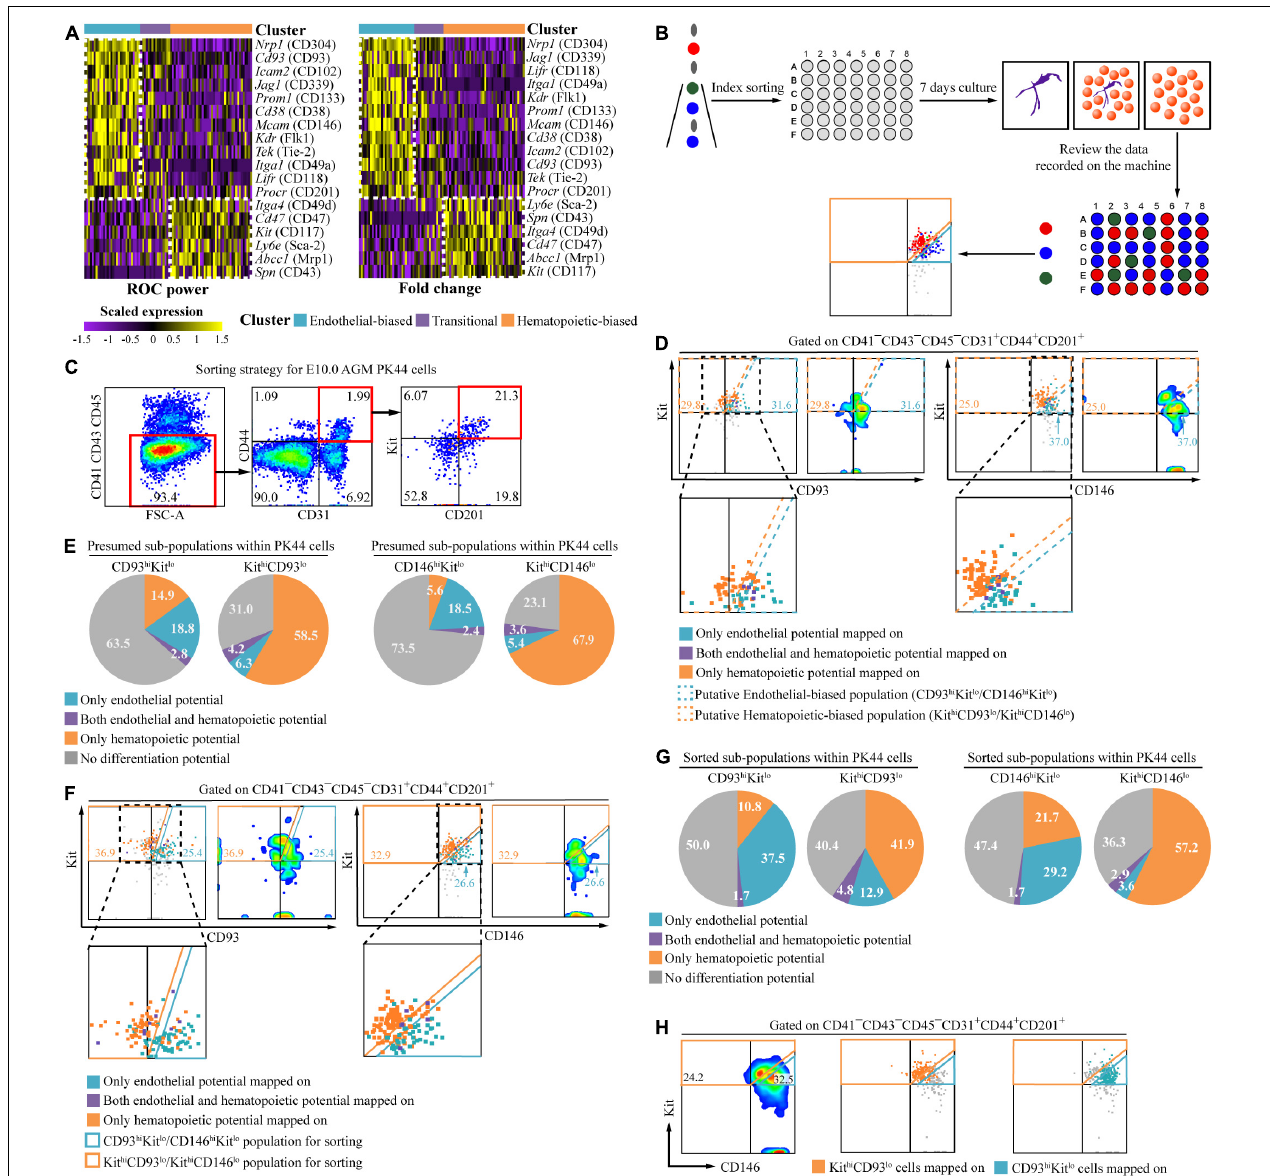
FIGURE 2 | Functionally different subpopulations within E10.0 AGM PK44 cells. (A) Heatmap showing the differentially expressed surface marker coding genes of the subpopulations in E10.0 AGM PK44 cells arranged by ROC power (left) and fold change (right), respectively. For the convenience of FACS labeling and live cell sorting, only genes coding cell surface proteins whose antibodies for FACS labeling are also commercially available in China within the DEG list are displayed. (B) Schematic experimental design of screening candidate molecules by index sorting. (C) Flow cytometry gating strategy for isolating PK44 population (CD41 - CD43 - CD45 - CD31 + CD44 + Kit + CD201 + ) from the E10.0 AGM region. (D) FACS plots showing expression of Kit and CD93/CD146 on the index-sorted E10.0 AGM PK44 cells. Cells with different kinds of potentials based on in vitro functional evaluation (color dots) are mapped onto the reference FACS plots (gray dots). Data are from four independent experiments. The enlarged views of dashed black boxes are shown below. (E) Pie charts showing the proportions of four differentiation potentials in the putative subpopulations. (F) FACS plots showing expression of Kit and CD93/CD146 on the index-sorted candidate subpopulations of E10.0 AGM PK44 cells. Cells with different potentials based on in vitro functional evaluation (color dots) are mapped onto the reference FACS plots (gray dots). Data are from four independent experiments. The enlarged views of dashed black boxes are shown below. (G) Pie charts showing the proportions of four differentiation potentials in each of the isolated subpopulations. (H) FACS plots of Kit and CD146 expression with the indicated subpopulations mapped on. Orange boxes indicate the gates of the Kit hi CD146 lo subpopulation; cyan boxes indicate the gates of the CD146 hi Kit lo subpopulation.